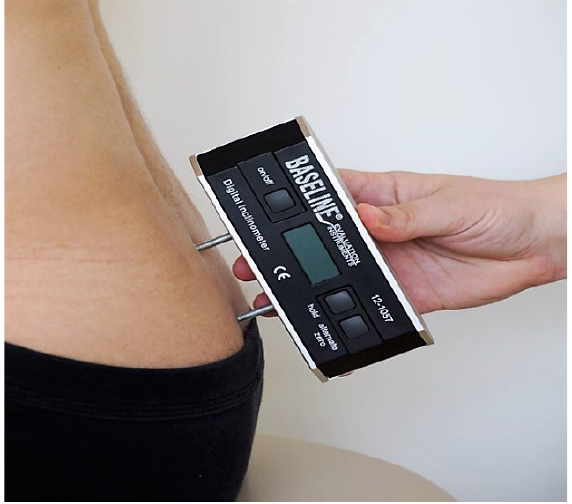
Figure 2. Sacrum angle measurement.